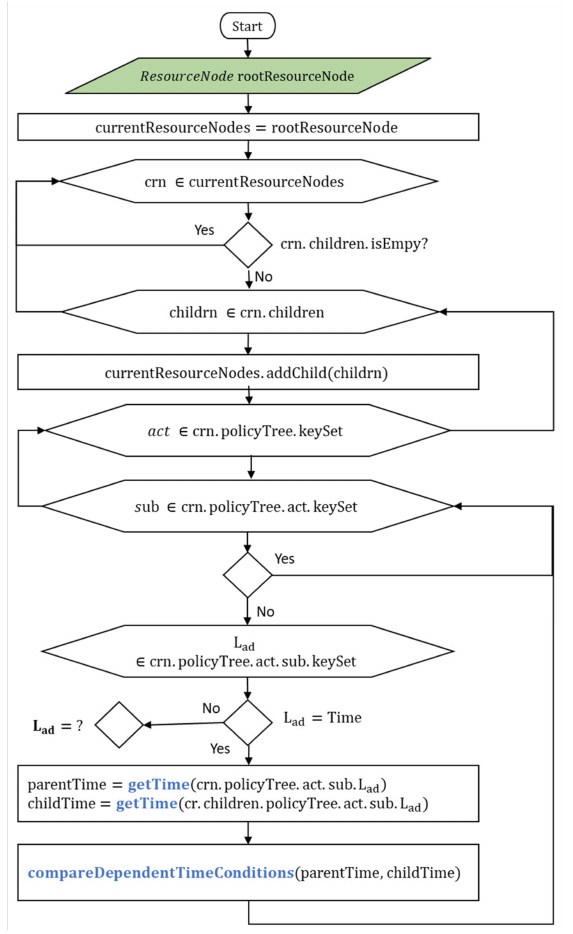
Figure 13. Dependent Resource Conflict Detection Algorithm Flow